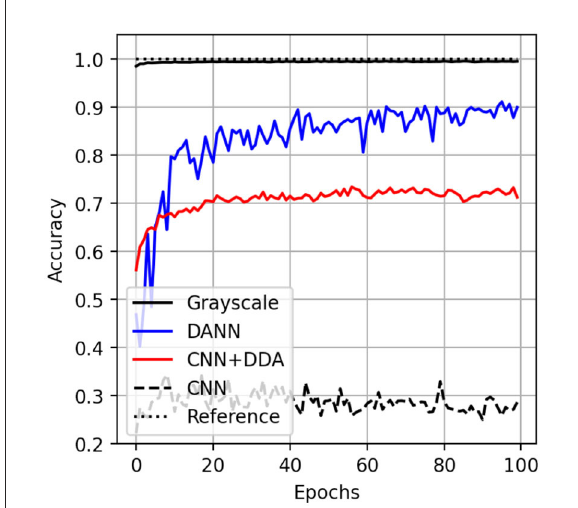
FIGURE6 The accuracy curves for application of trained networks on test partition of MNIST (solid black) and MNIST-M (other) datasets. The inference score on MNIST-M by CNN (dashed), DANN (blue) and proposed method (CNN + DDA, red). The perfect score is shown as a dotted line at 1.